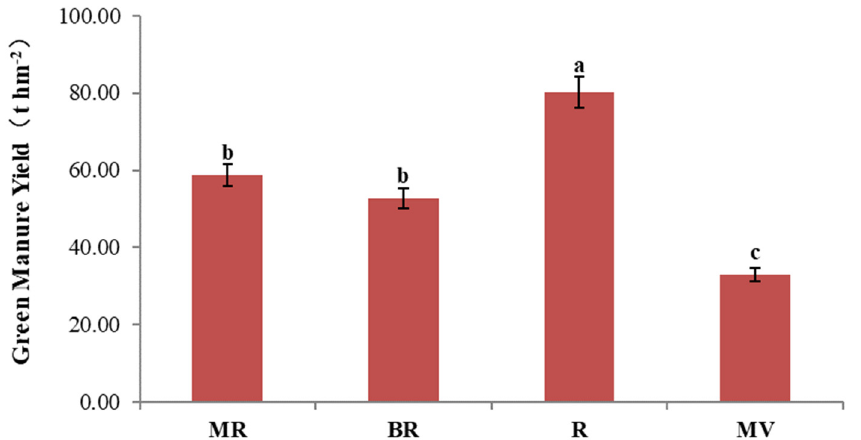
Figure 3. Comparison of different green manure yield. Legend: Values followed by different letters represent significant differences between different green manure species ( p < 0.05); MR—mustard rape, BR—brassica rape, R—radish, MV—milkvetch.